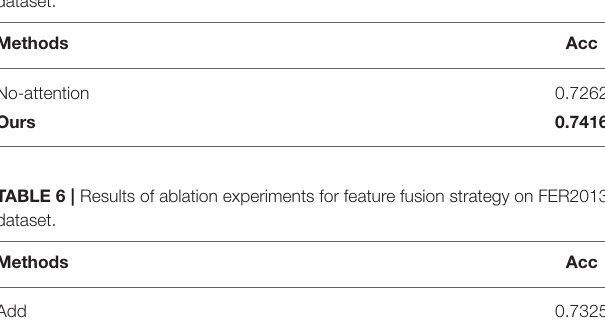
TABLE 5 | Results of ablation experiments for attention mechanism on FER2013 dataset.